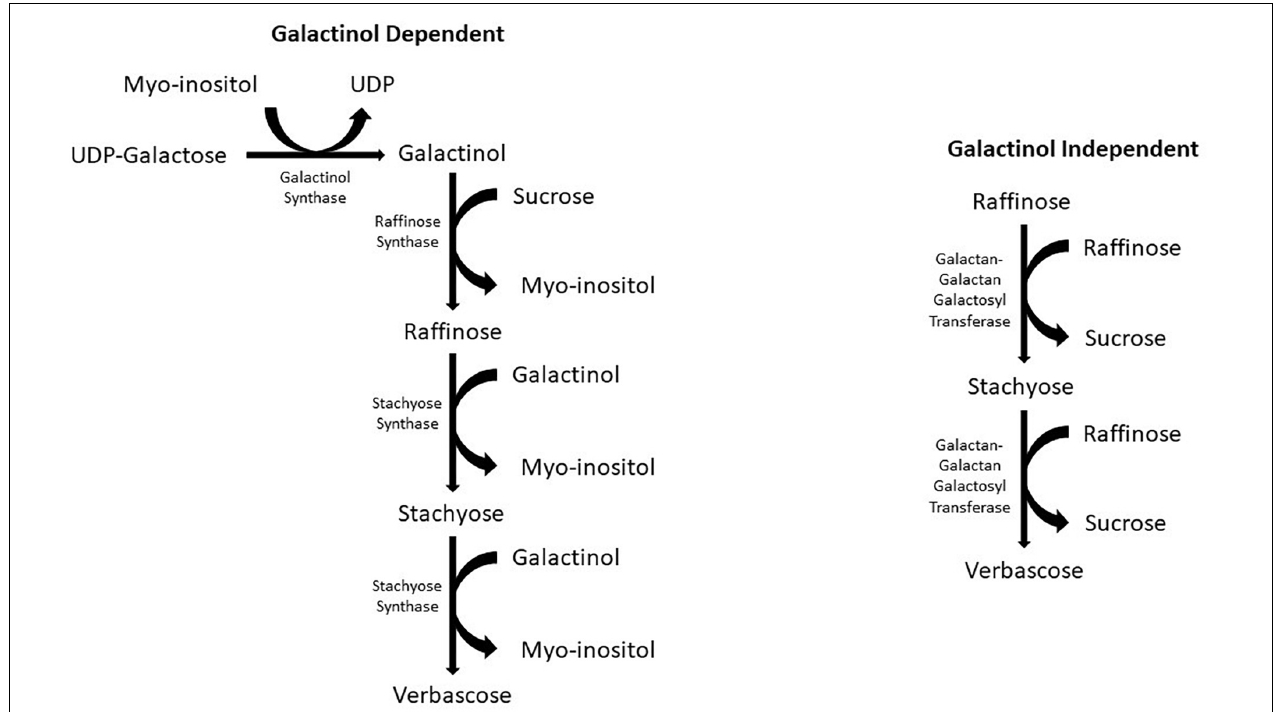
FIGURE 1 | Galactinol dependent and independent biosynthetic pathways for RFO biosynthesis in crop plants.